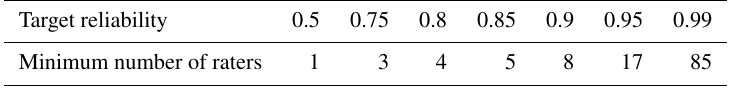
Table 2. Number of raters within the larger sample of student raters required to achieve a target ICC value. Calculated from the ICC for the entire sample of student raters ( n = 71) using the Spearman–Brown prediction formula. Number of raters is rounded up to the nearest